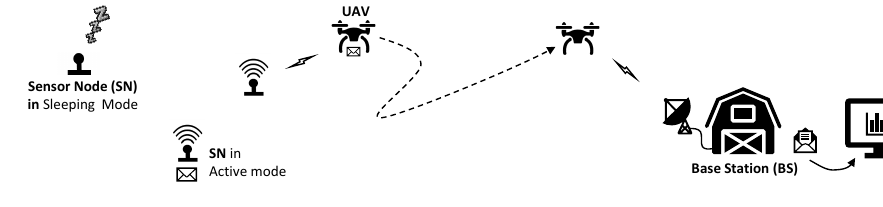
Figure 1. System